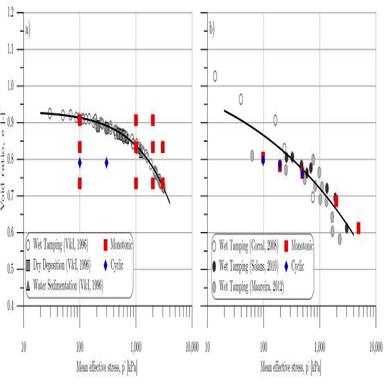
Critical state line and selected tests for: a) Toyoura sand, and b) El Torito tailings sand.